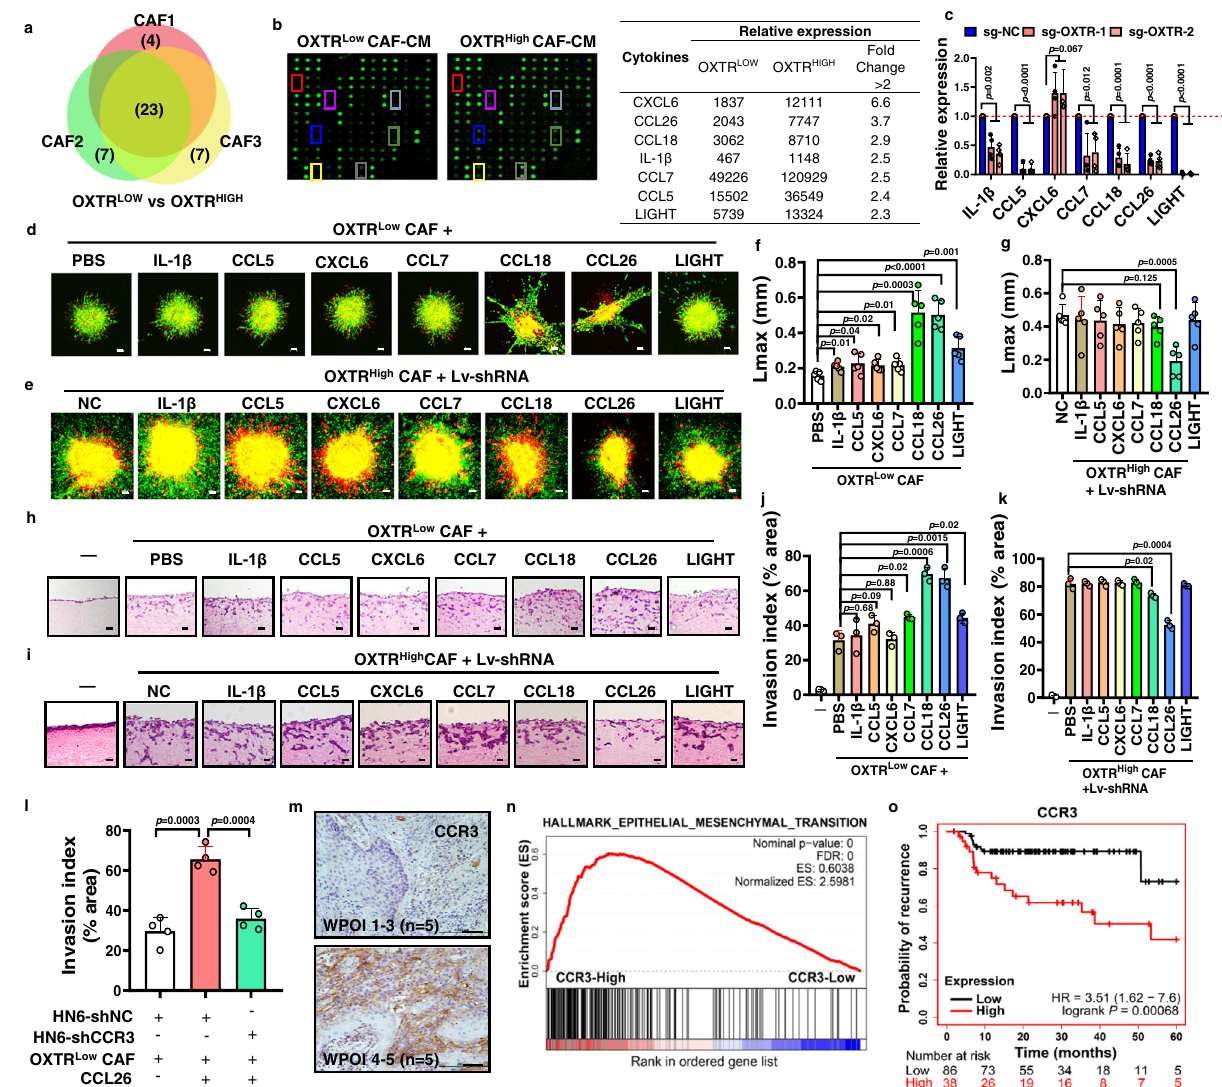
Fig. 5 | CCL26 isrequiredfor OXTR High CAFsfunction. a Cytokines secretedfrom OXTR Low and OXTR High CAFs sorted from three individual CAF cell lines (CAF1-3), displayed as a venn diagram, with the numbers of overlapping cytokines indicated (left image). The numbers of shared cytokines elevated in all OXTR High CAFs are indicated ( n =23). b The scan map of Human Cytokine array (middle) ( n =3 inde- pendent samples for each group). Table (right) displays seven cytokines/chemo- kineswhichweresigni fi cantlydifferentlyupregulated(foldchange>2)inthemedia of OXTR High CAFs. c Relative expression (RT-PCR) of seven cytokines/chemokines after OXTR knockdown in OXTR High CAFs. P =multiple t test. n =4 for each group. d , e Representative images of DiI-labeled conditional CAFs (red) co-cultured with CMFDA-labeled HN6 (green) to form heterotypic spheroids for organoid invasion studies. Cultured cells were supplemented with recombinant human CXCL6, CCL26, CCL18, IL-1 β , CCL7, CCL5, or LIGHT or stable knockdown of each of seven cytokines/chemokines.Scalebar:100 μ m. f , g Graphicalrepresentationofmaximal distance of spheroid invasion from the spheroid border (Lmax) in ( d , e ) and